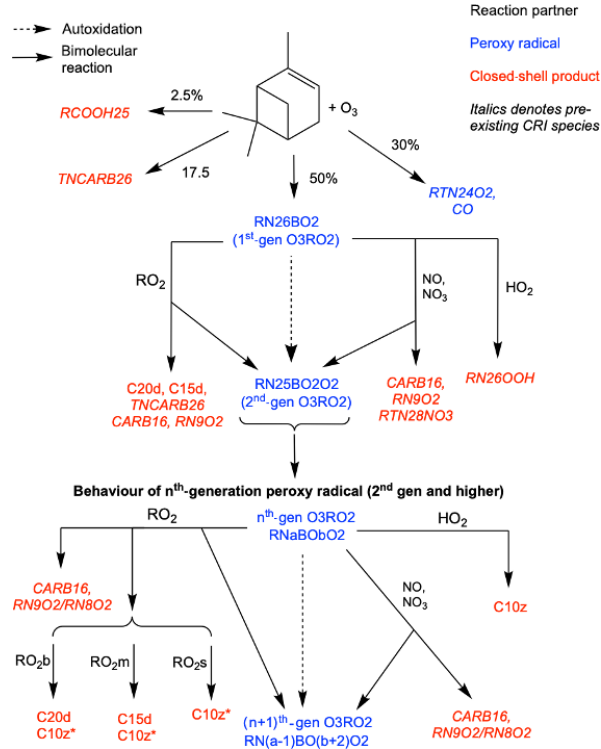
Figure 1. Schematic of additions to CRI v2.2 to represent autoxida- tion and HOM formation via ozonolysis of α -pinene. HOMs (C10z, C15d, C20d) can be produced via reaction of O3RO2 with HO 2 and RO 2 , while reaction with NO, NO 3 and RO 2 can produce alkoxy radicals which can fragment or isomerise. New species introduced in this scheme are denoted by normal font; existing species are de- noted by italics. The RO 2 pool is split into subsections covering big (RO 2 b), medium (RO 2 m) and small (RO 2 s) peroxy radicals to facilitate addition of accretion product